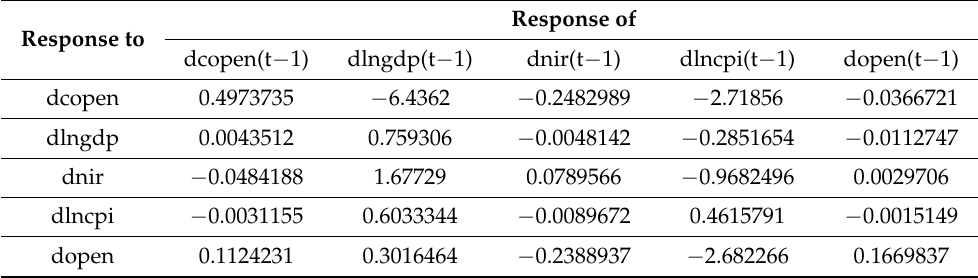
Table 8. Generalised Method of Moments (GMM) Panel Vector Autoregression Model for Trade